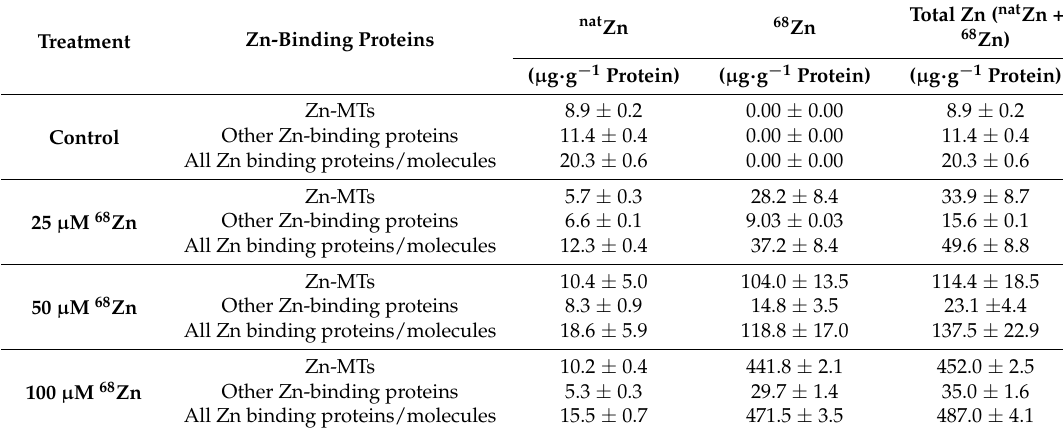
Table 1. Concentration of nat Zn, 68 Zn and total Zn ( nat Zn + 68 Zn) (in µ g · Zn · g − 1 protein) found in Zn binding-proteins/molecules, i.e., MTs, other than MTs and all Zn-binding proteins/molecules, in